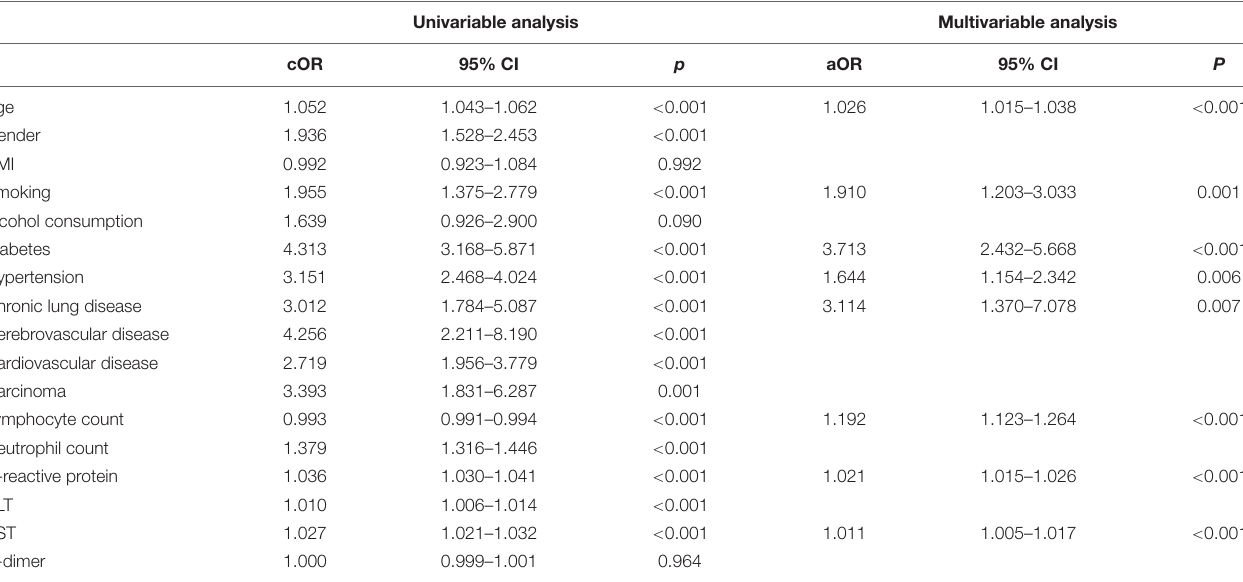
TABLE 2 | Risk factors associated with severe illness by logistic